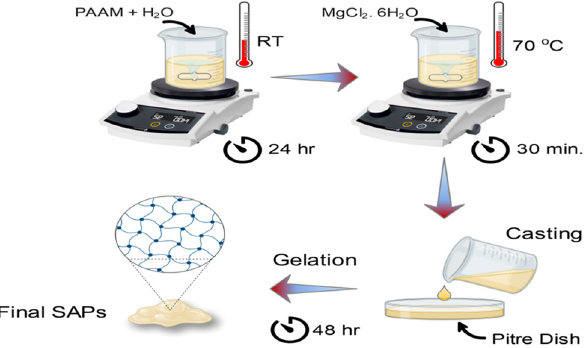
Figure 1: The preparation steps of Mg - KPA SAPs.